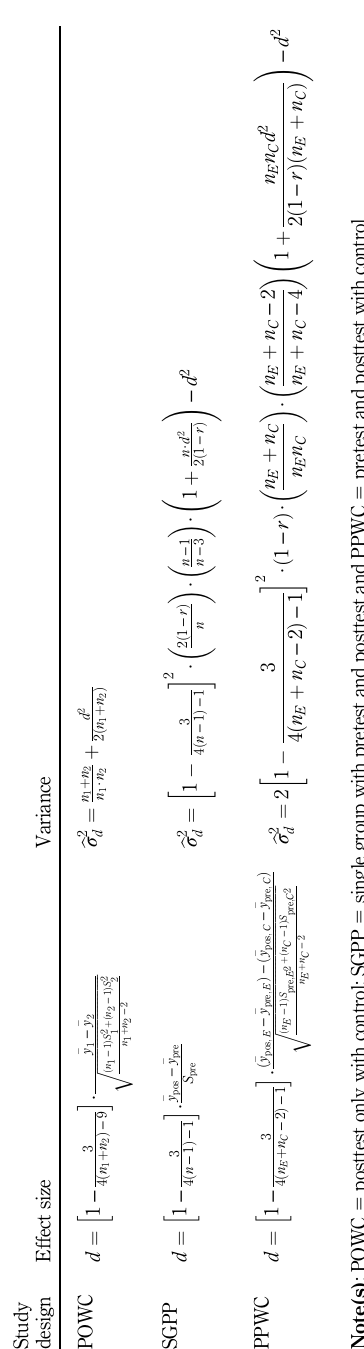
Table 4. Effect size